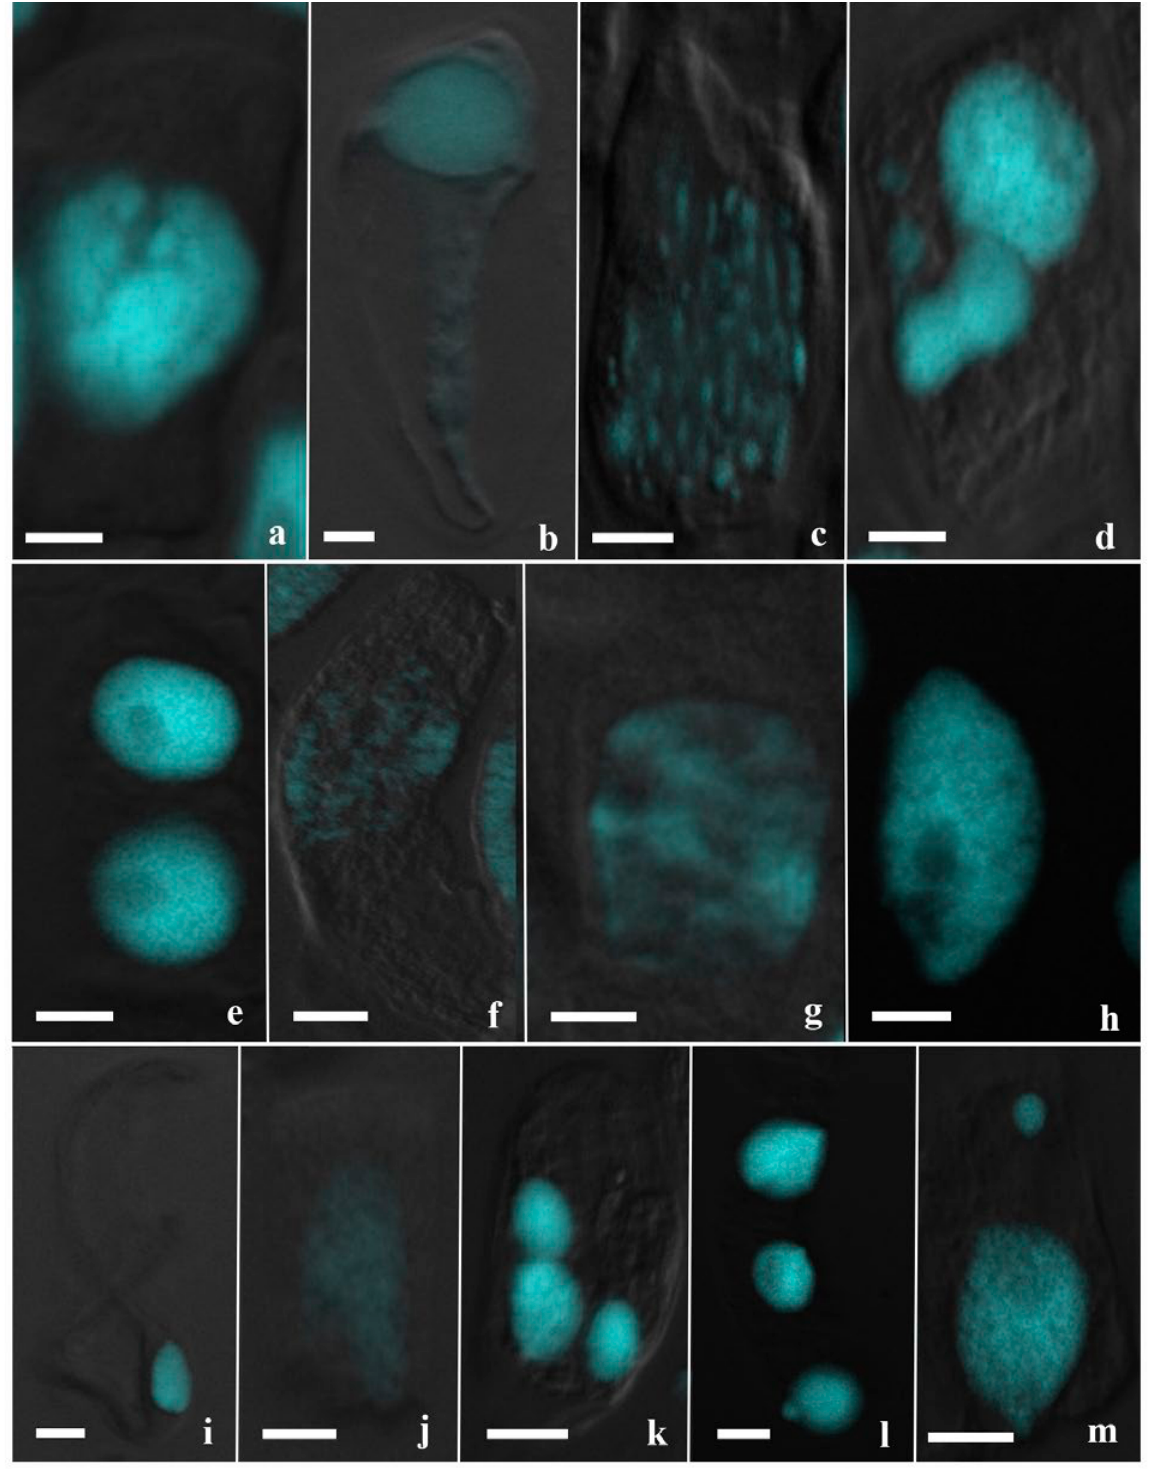
Fig. 3. Chromosomal aberrations induced by extract of C. viminale on A. cepa . a: apoptotic breakage of nucleus at interphase; b: